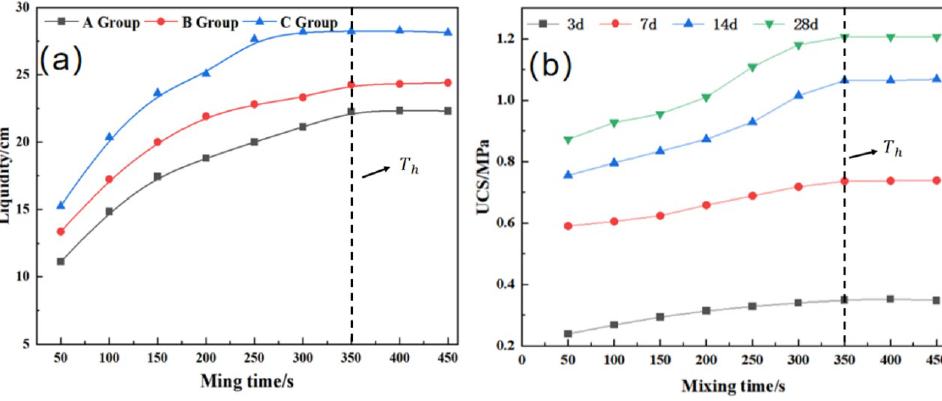
Figure 9. Flow expansion ( a ) and mechanical properties ( b ) of group A.